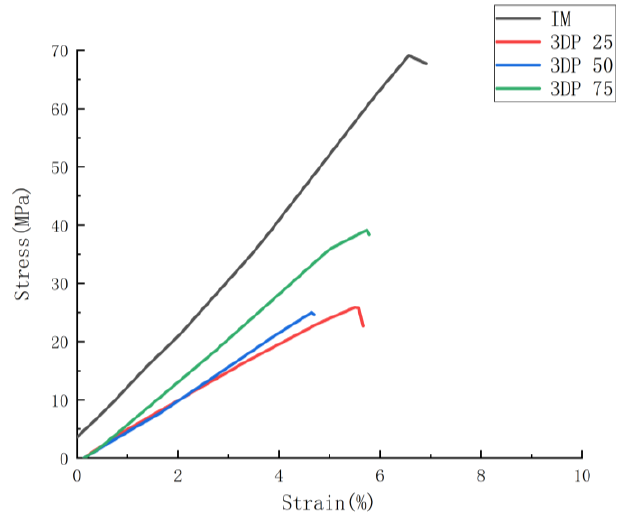
Figure 5. Average stress-strain curves for IM and FDM samples.